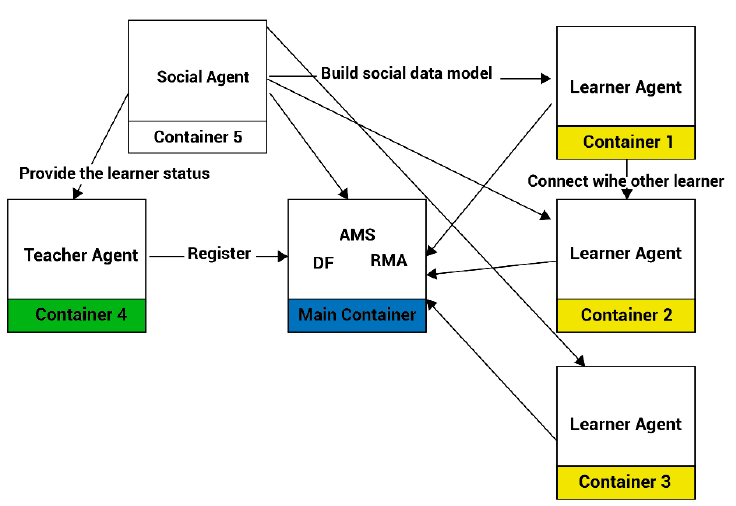
Figure 10. Proposed architectural design for collaborative mobile learning platform using JADE-LEAP.